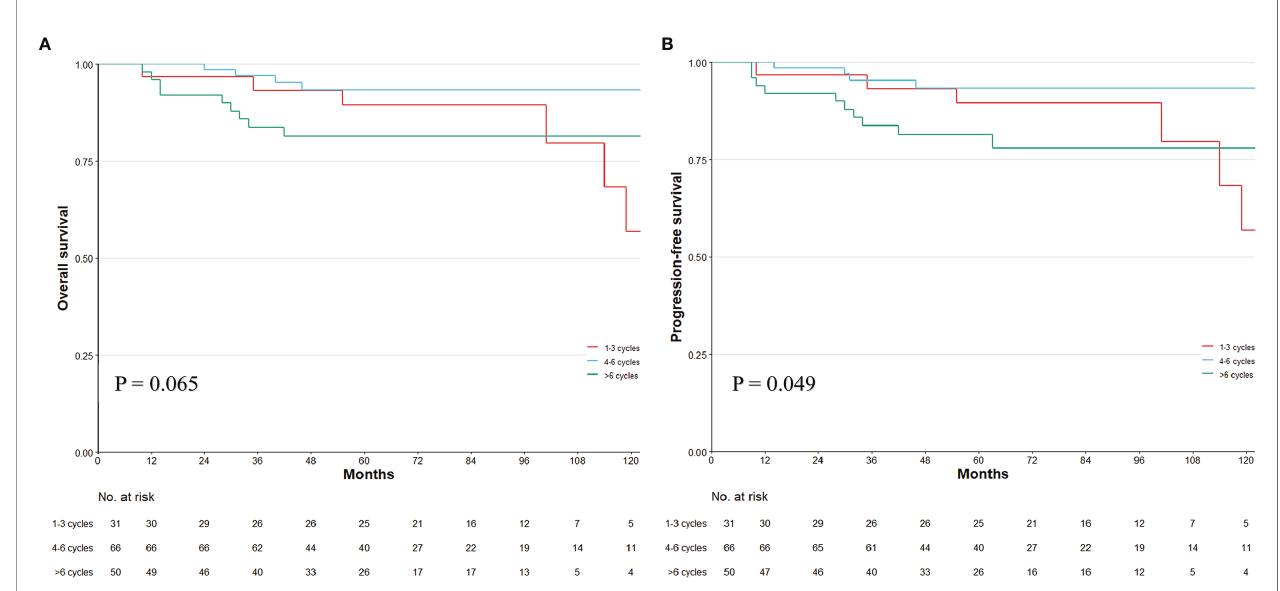
FIGURE 9 | Kaplan – Meier survival plot of the overall survival (OS) and progression-free survival (PFS) in different PEC duration of three tiers in ypT0-2N0 patients. p- value stands for log-rank test. Numbers at bottom indicate patients at